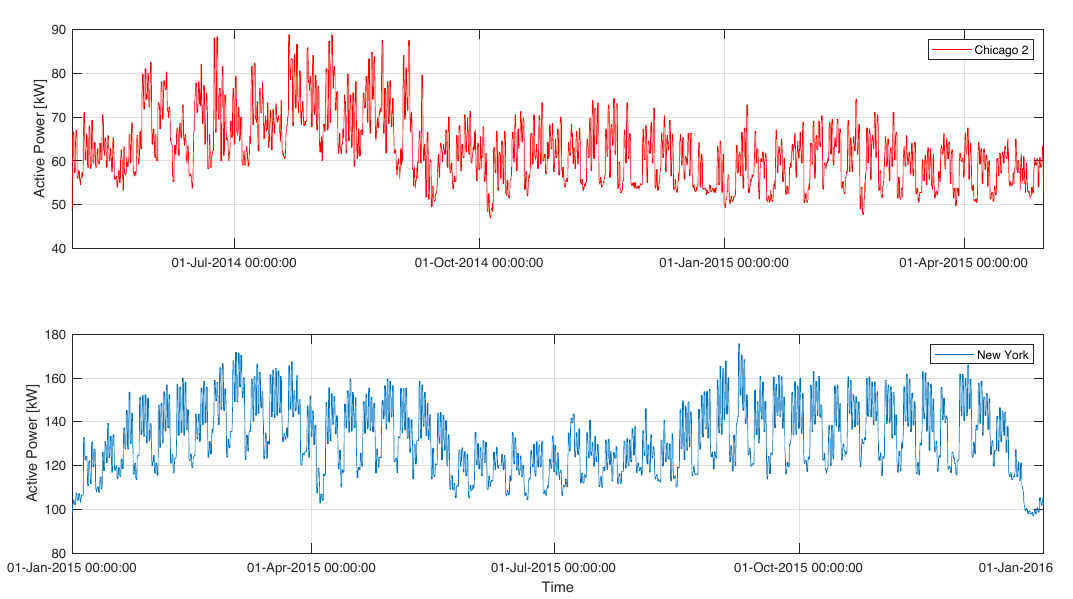
Figure 4. Input data for LSTM training and validation: Chicago 2 and New York